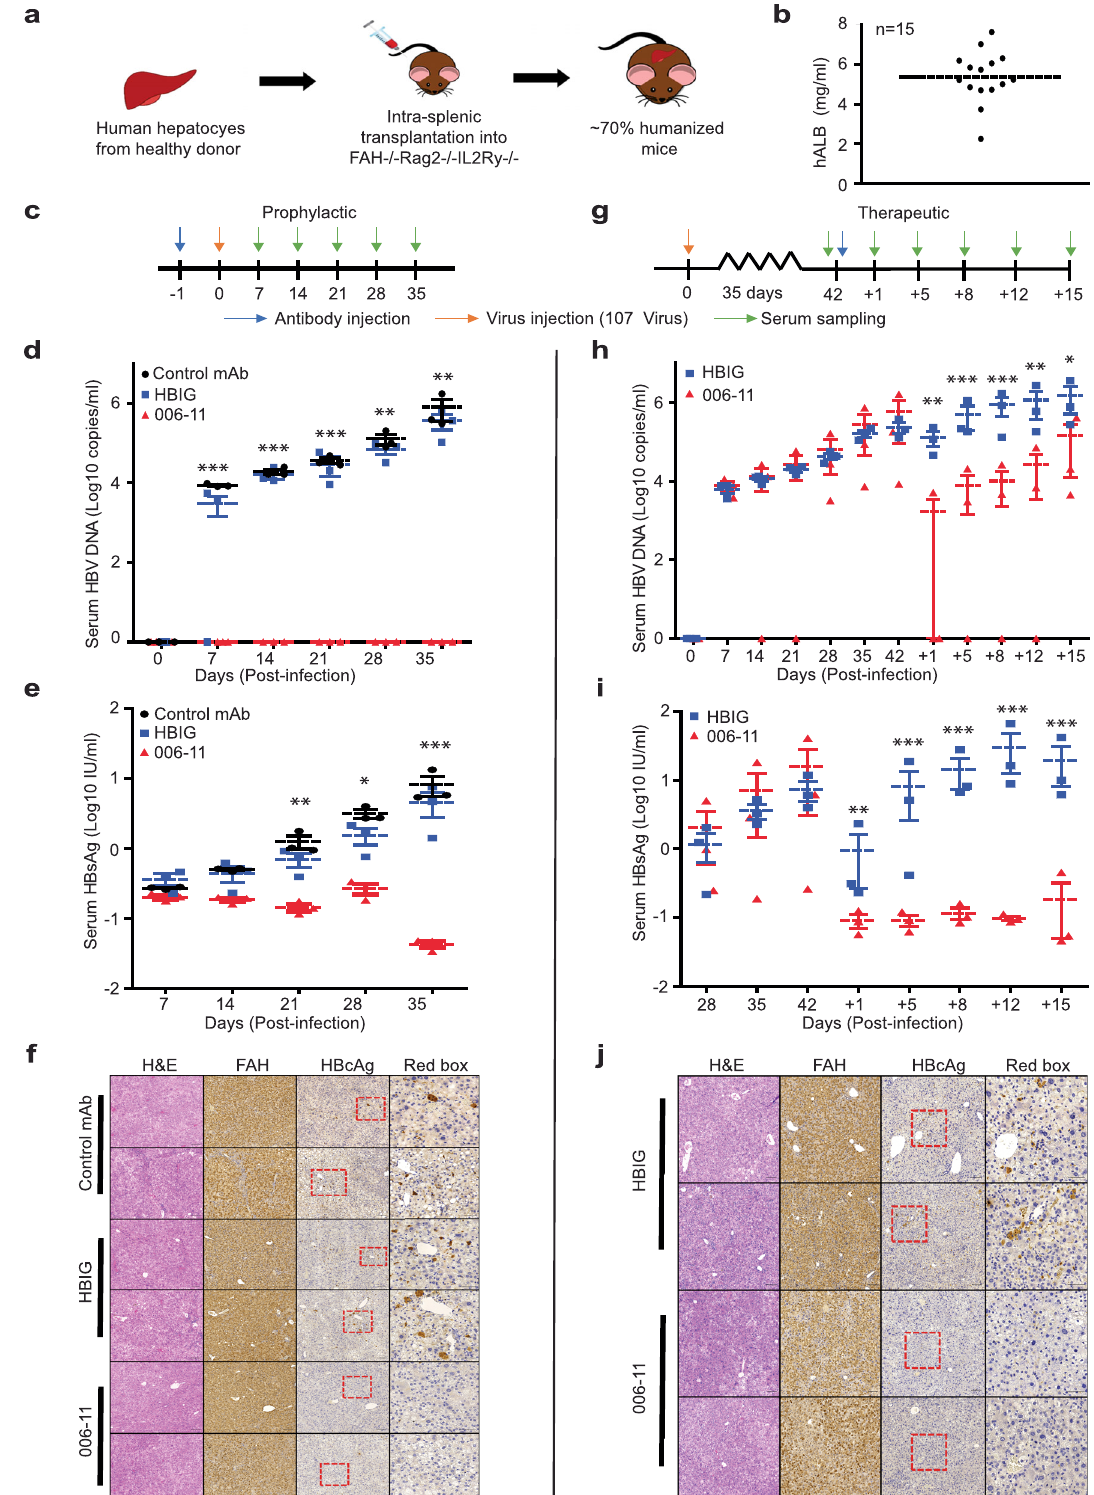
Having observed potent prophylactic and post-infection anti-viral ef fi cacy of HuMAb006-11 in vivo, we next compared the prophylactic ef fi cacy of a single dose of HuMAb006-11